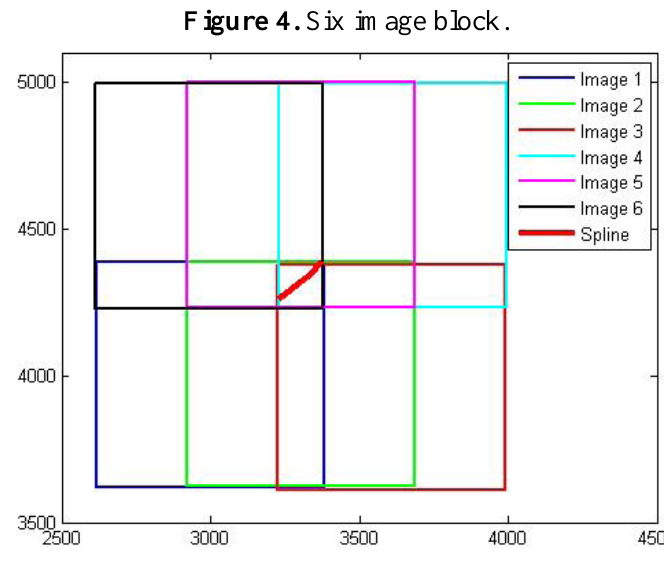
Figure 4. Six image block.